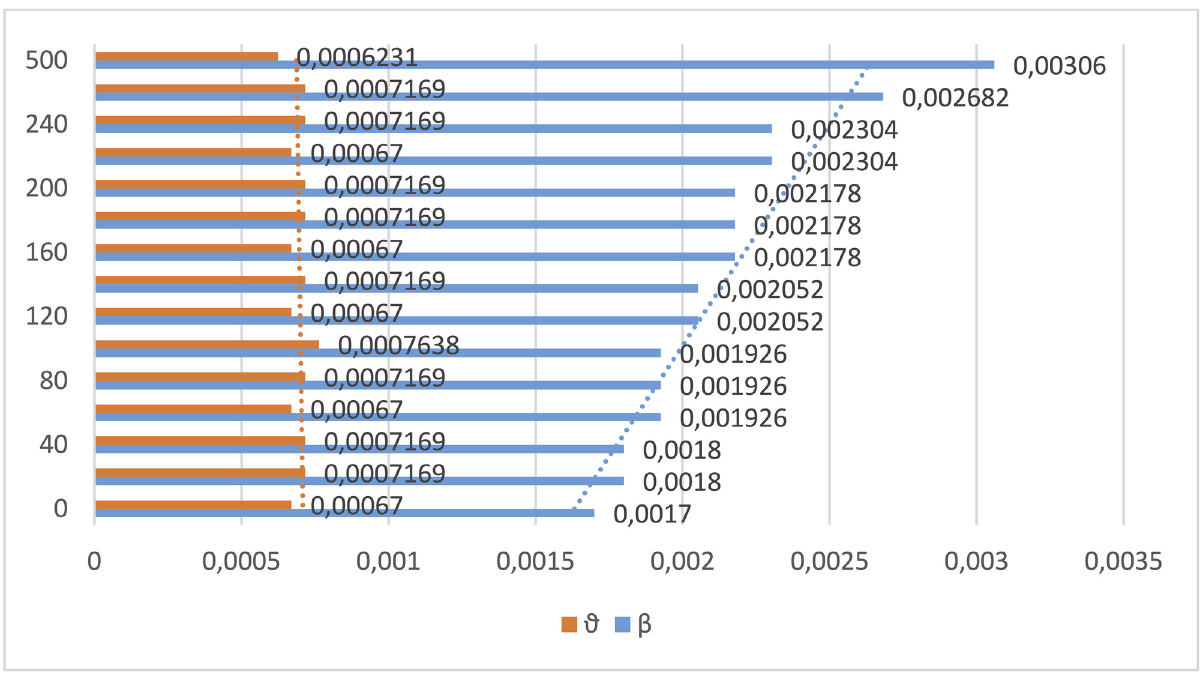
Fig 9. Values and trends for the parameters W and β fitted for the model (17) for different rewiring rates ν = 0 ... 500, corresponding to the curves represented in Fig